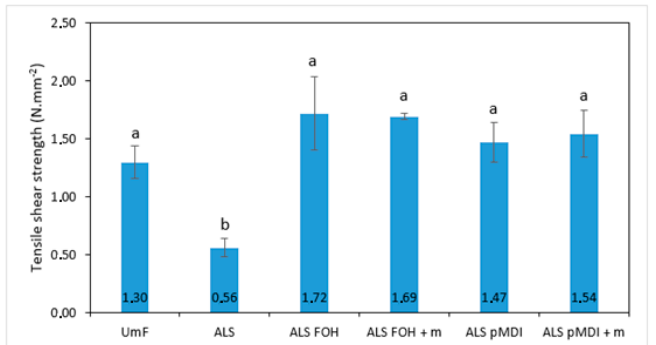
Figure 2. Tensile shear strength of 2-layered beech samples bonded with urea-melamine-formaldehyde (UmF), ammonium lignosulfonate (ALS), ALS crosslinked with furfuryl alcohol (ALS FOH), ALS FOH with mimosa tannin (ALS FOH + m), ALS crosslinked with pMDI (ALS pMDI) and ALS pMDI with mimosa tannin (ALS pMDI + m). Each column is the average of 10 determinations, and error bars represent standard deviations. Values labeled with di ff erent letters (a and b) are statistically di ff erent at an error probability of α = 0.05 (ANOVA and Tukey’s HSD tests). UmF, melamine reinforced urea-formaldehyde; HSD, honestly significant di ff